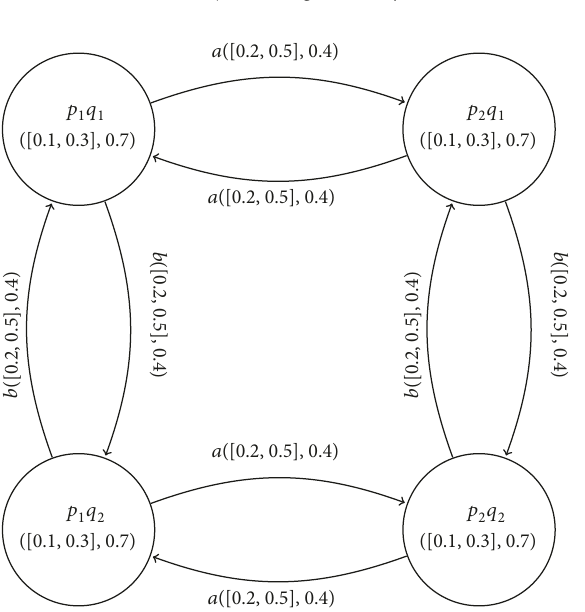
Figure 11: ̂𝜑 ∘ ̂𝜓 is not a good